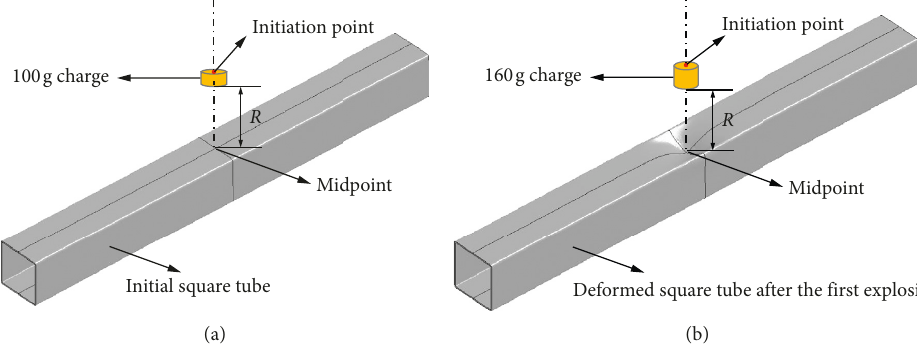
Figure 2: Stand-off distance description of the first and second explosion test. (a) The first explosion of double-explosion test. (b) The second explosion of double-explosion test. Table 3: Detailed experimental data of the single- and double-explosion tests. Test